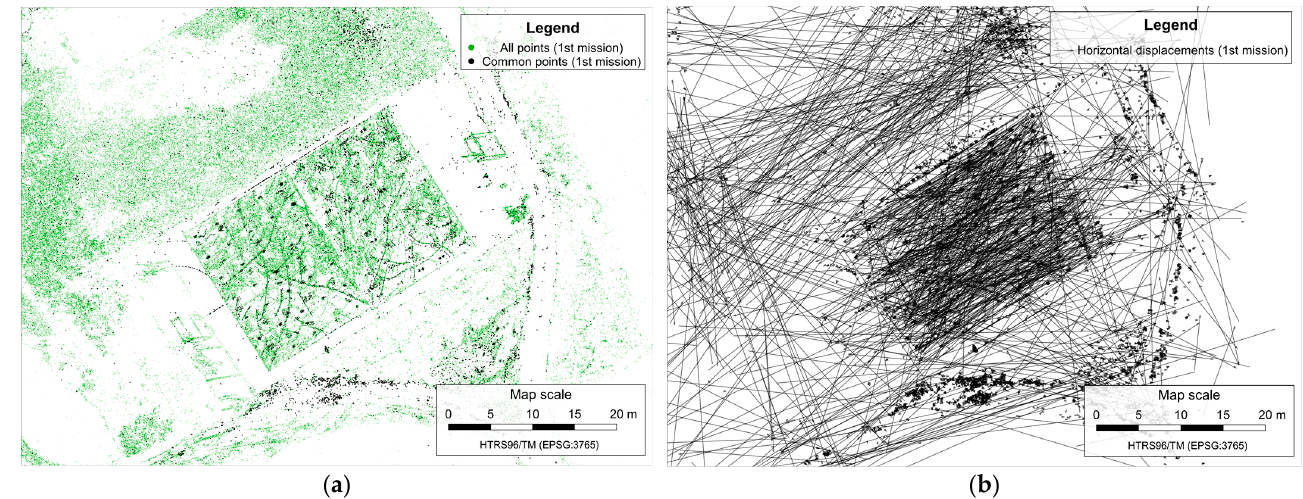
Figure 6. All reconstructed points with highlighted common feature points in the first mission ( a ), and determined horizontal displacements vectors ( b ).